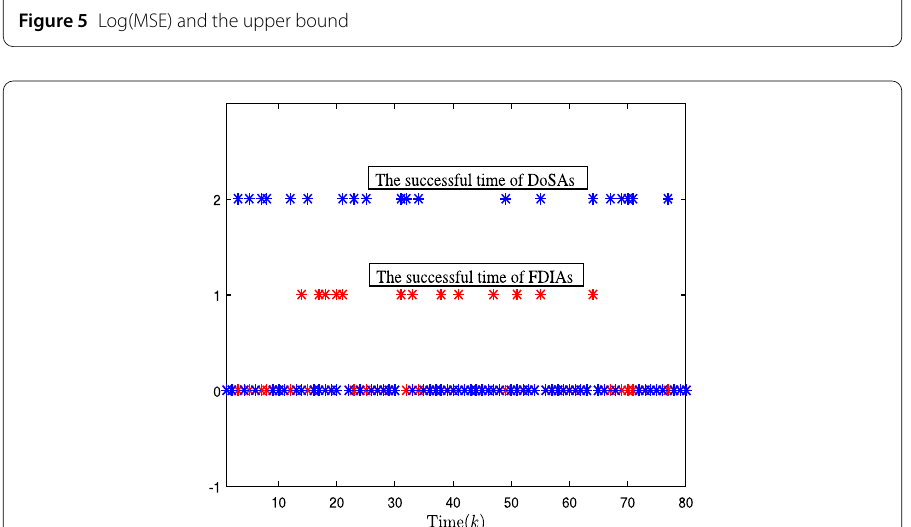
Figure 5 Log(MSE) and the upper bound